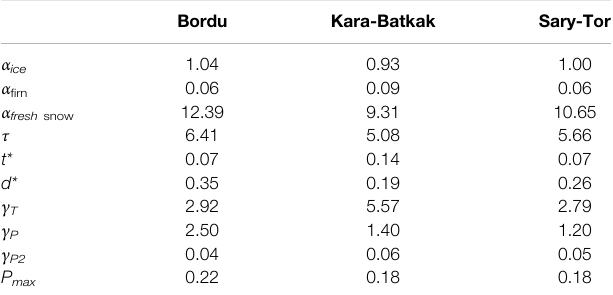
TABLE 8 | Sensitivity of the mass balance to changes in the different parameters. Sensitivity is de fi ned as %MB change per 10% parameter change.